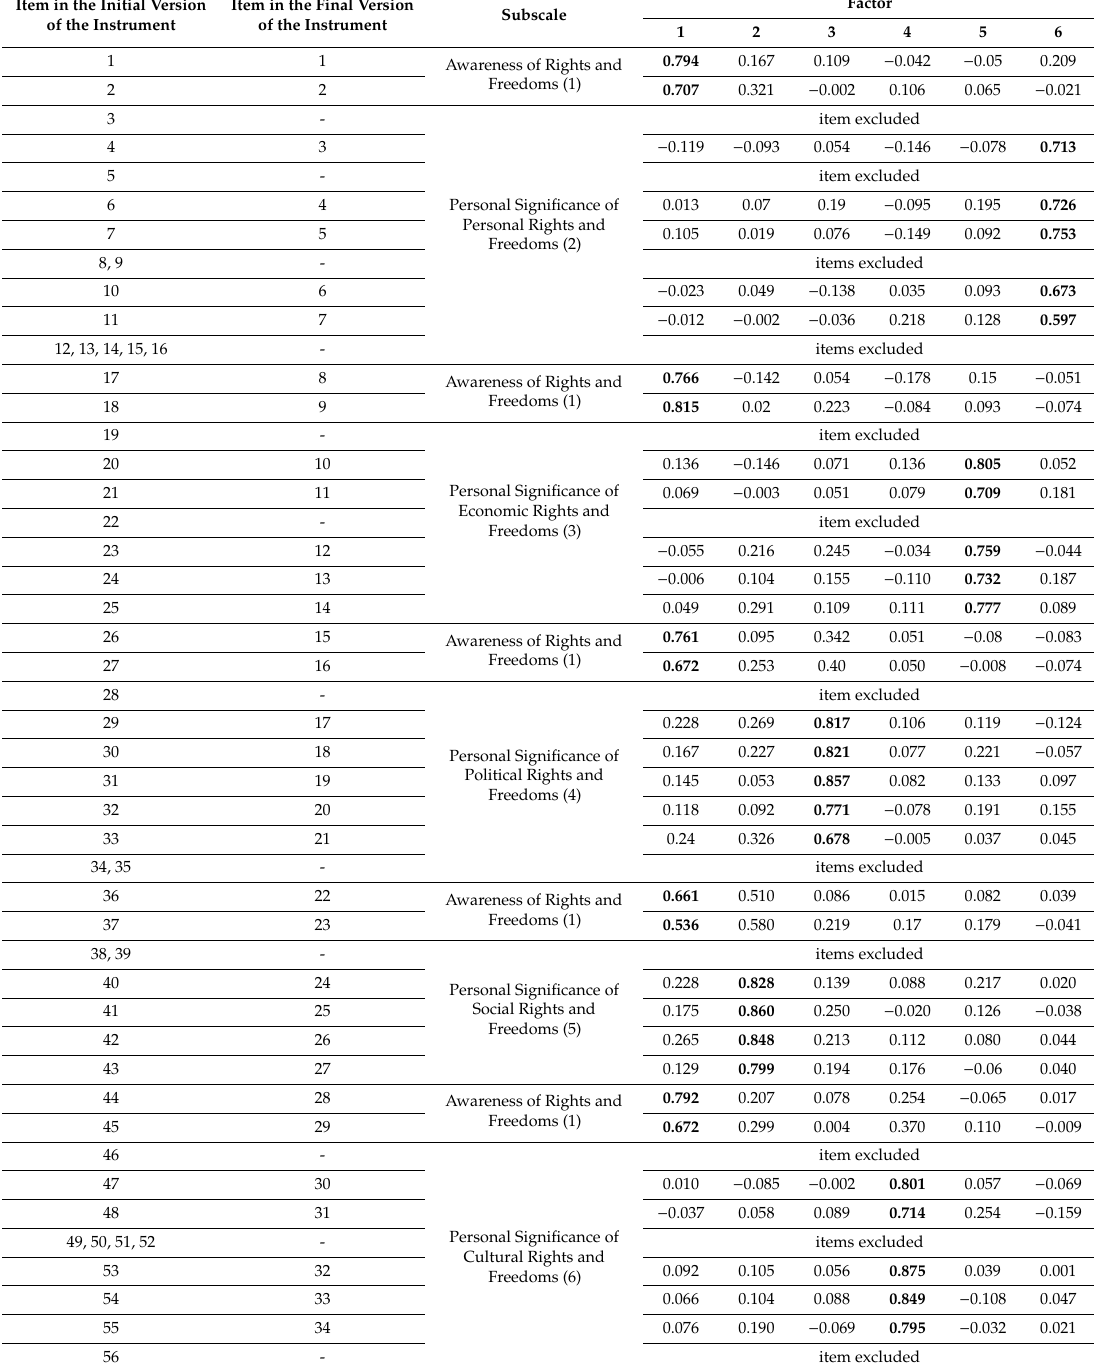
Table 4. Factor loadings (Varimax rotation, Principal